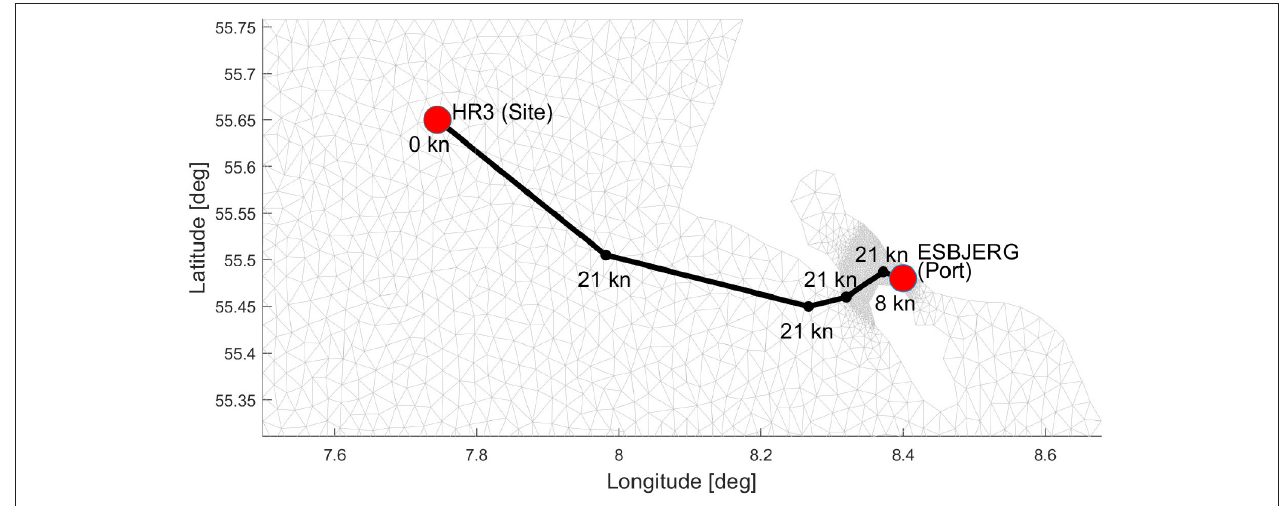
FIGURE 7 | Prescribed track and speeds for the transfer of the CTV from the Port to the Site and then back to the